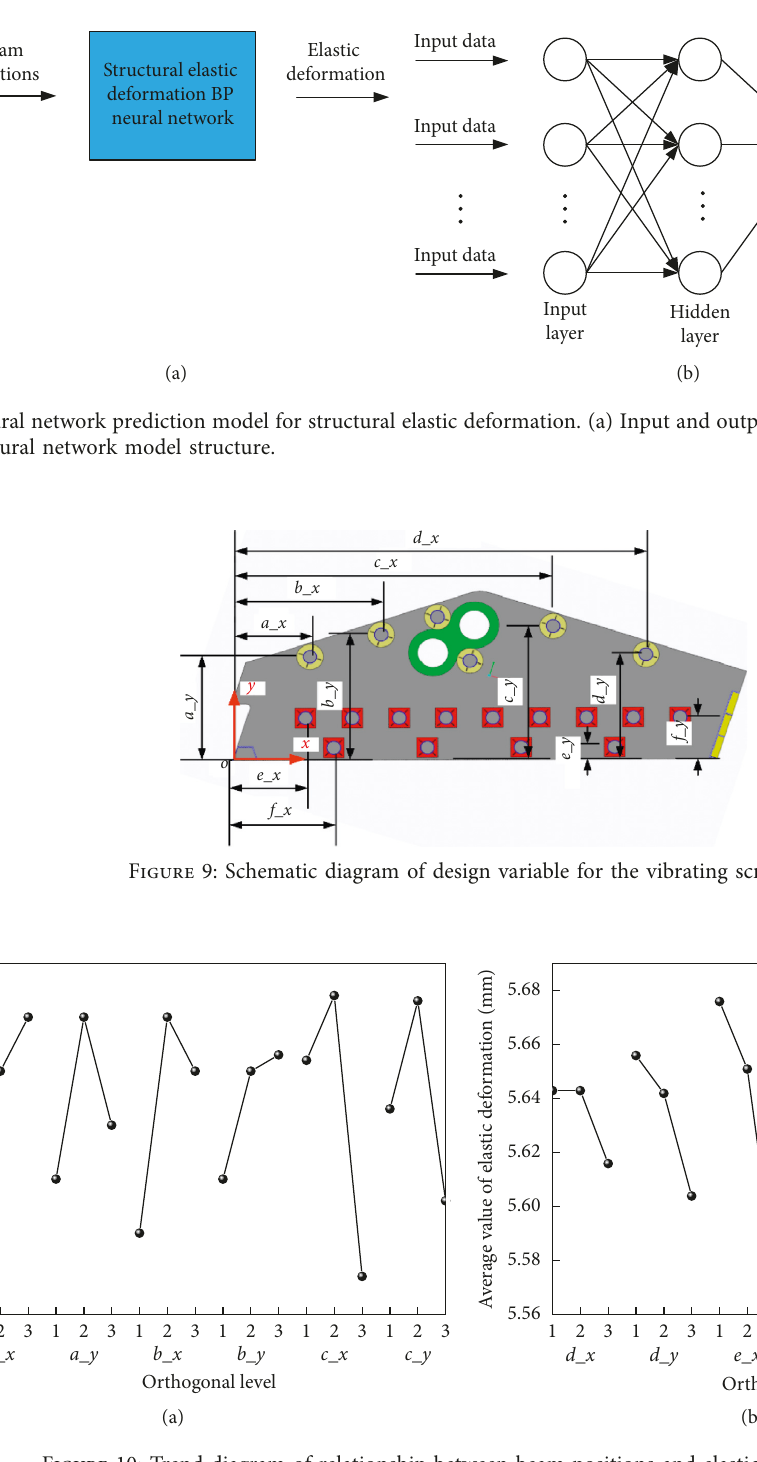
Figure 10: Trend diagram of relationship between beam positions and elastic